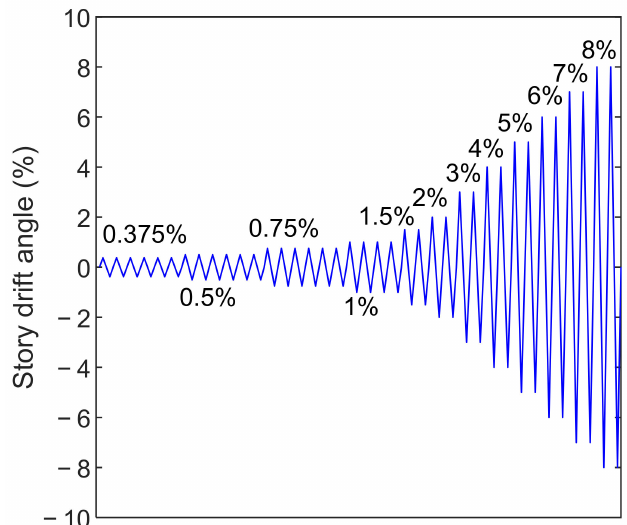
Figure 2. Cyclic loading